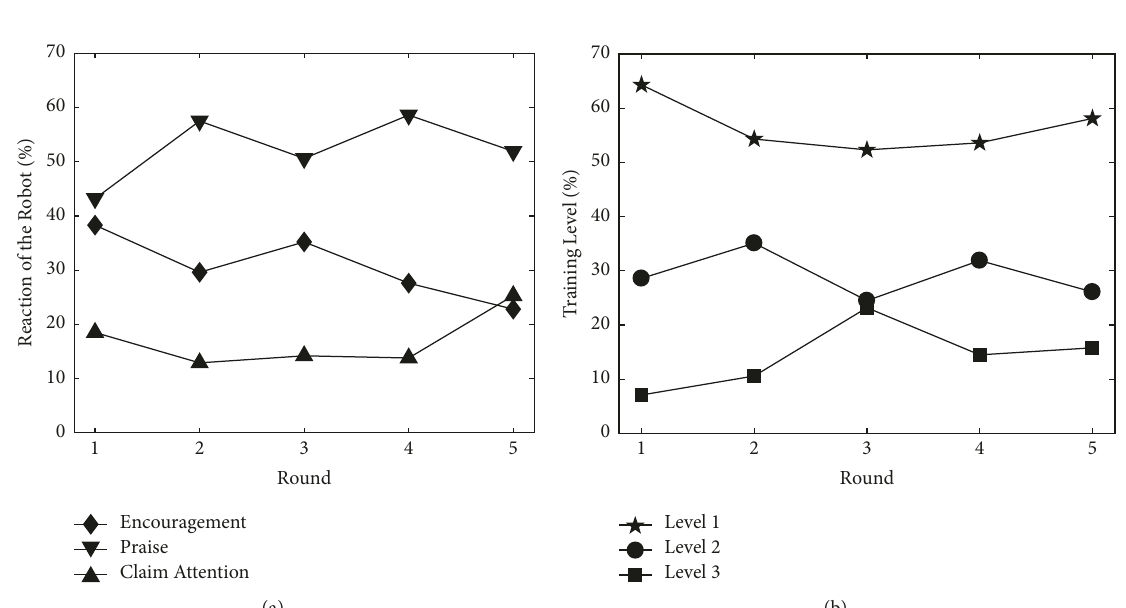
Figure 11: The distribution rate of training levels and the robot’s feedback for the child A in the